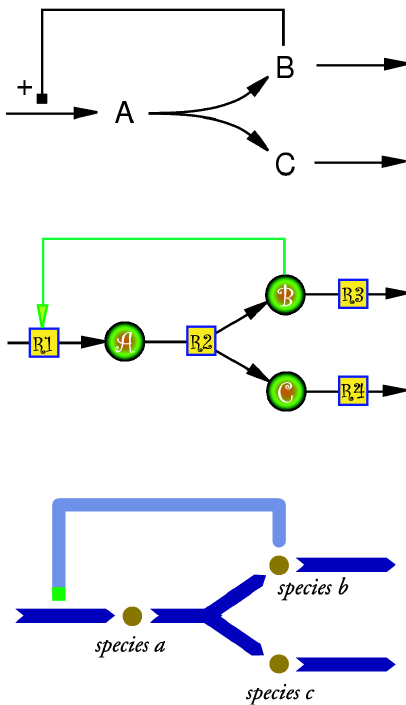
Figure 1: Examples of different render- ings of the same